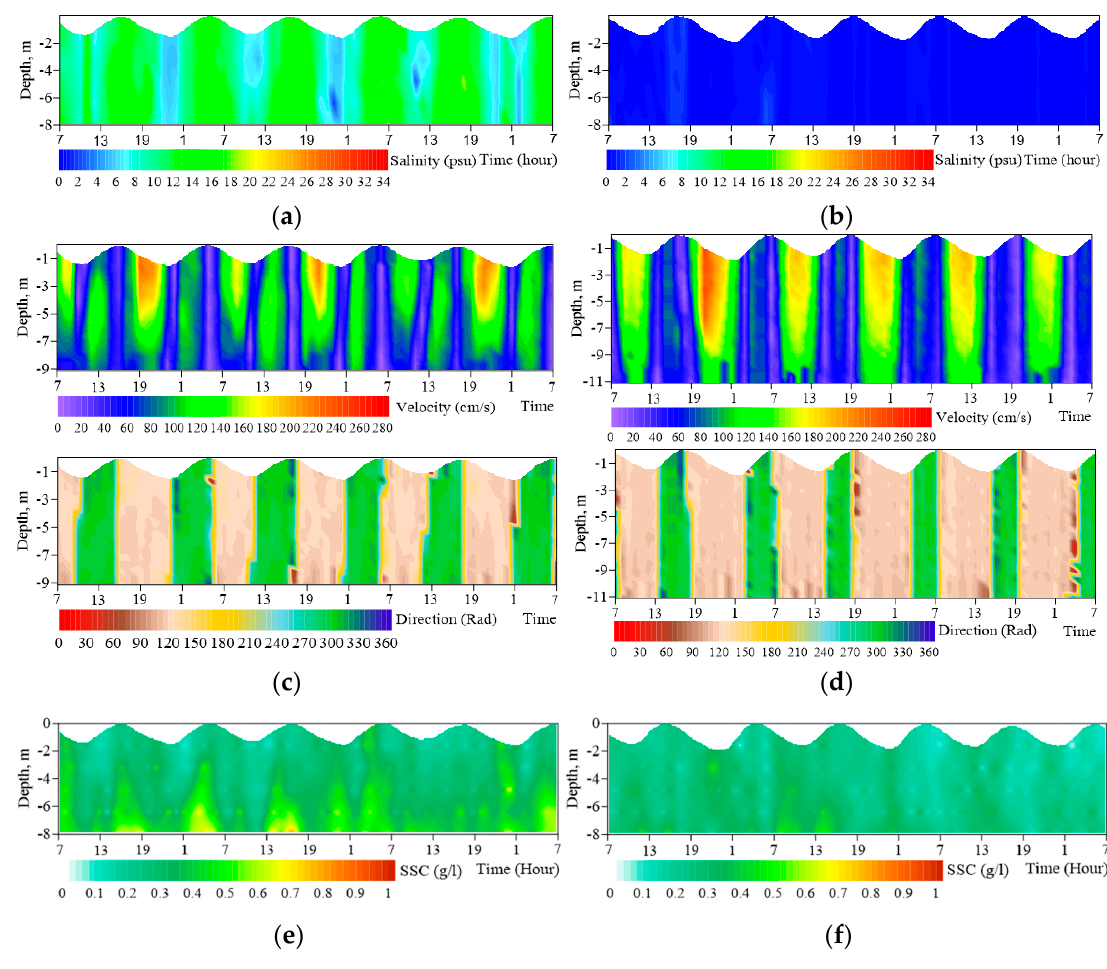
Figure 5. Time series plot of the distribution of salinity, currents (velocity, direction), and SSC at Station D2 in the dry season (9–12 April 2009) and the flood season (22–25 August 2009): ( a ) salinity in the dry season; ( b ) salinity in the flood season; ( c ) current in the dry season; ( d ) current in the flood season; ( e ) SSC in the dry season; ( f ) SSC in the flood season.